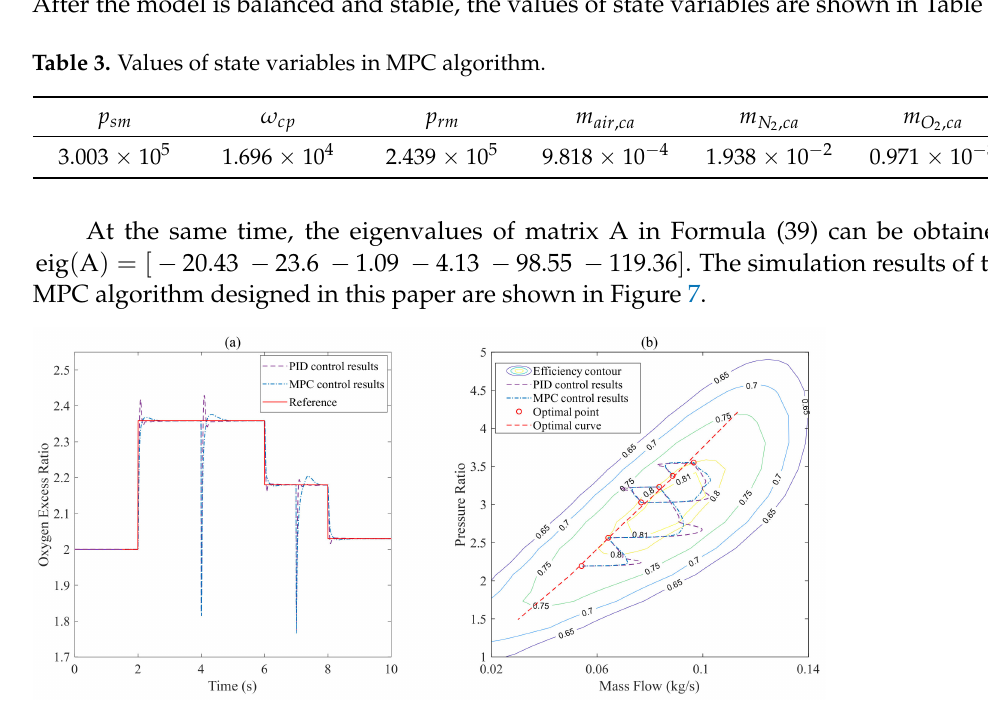
Figure 7. MPC algorithm simulation results: ( a ) oxygen excess ratio following curve; ( b ) Compressor mass flow and pressure ratio